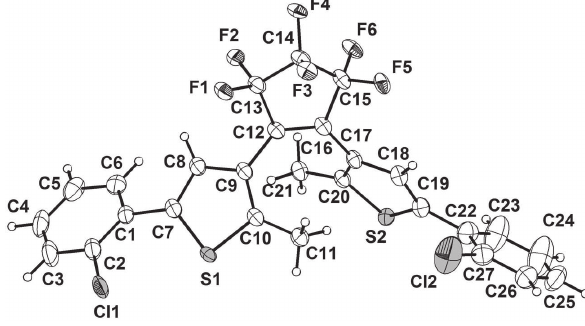
Table 1: Data collection and